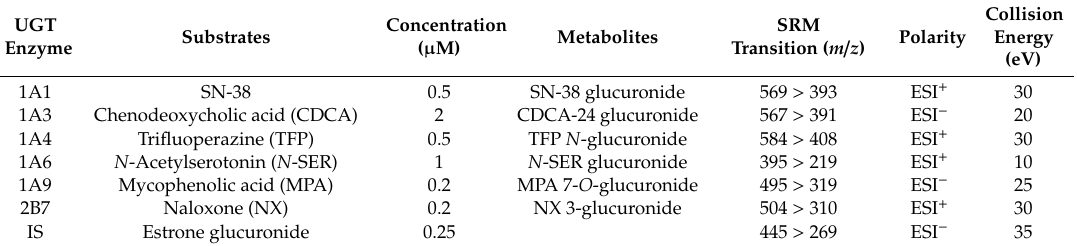
Table 2. Selected reaction monitoring (SRM) condition for the major metabolites of the six uridine 5 (cid:48) -diphosphoglucuronosyl transferase (UGT) enzyme substrates and internal standard